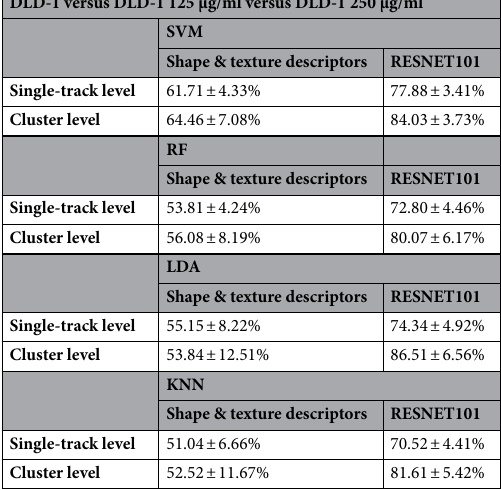
Table 5. Accuracy values of four classification models (SVM, RF, LDA, and KNN) built on shape and texture descriptors, compared with the results obtained using RESNET101 transfer learning descriptors.